Question: Briefly state, in one sentence, what is plotted here.
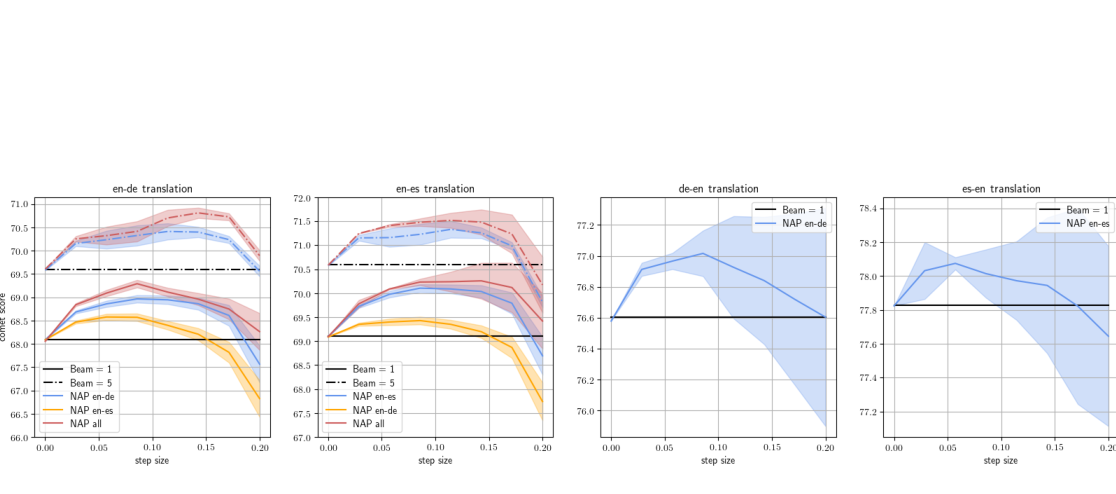
Answer: Modifying encoder outputs using the gradient of a NAP. This shows how the performance changes when we vary the step size α of the modification. The error represents 1 standard deviation. The various figures show the translation task in the title and NAPs (data each was trained on) in the legend.